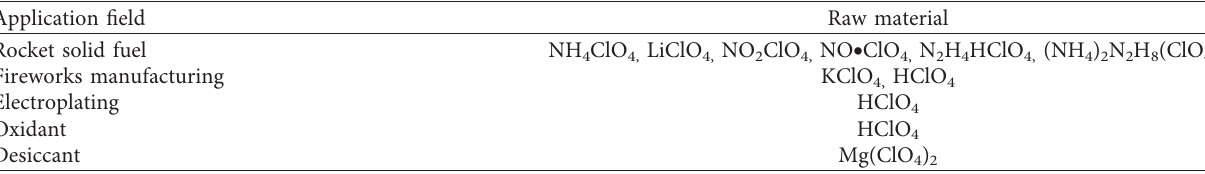
Table 1: Applications of perchlorate.